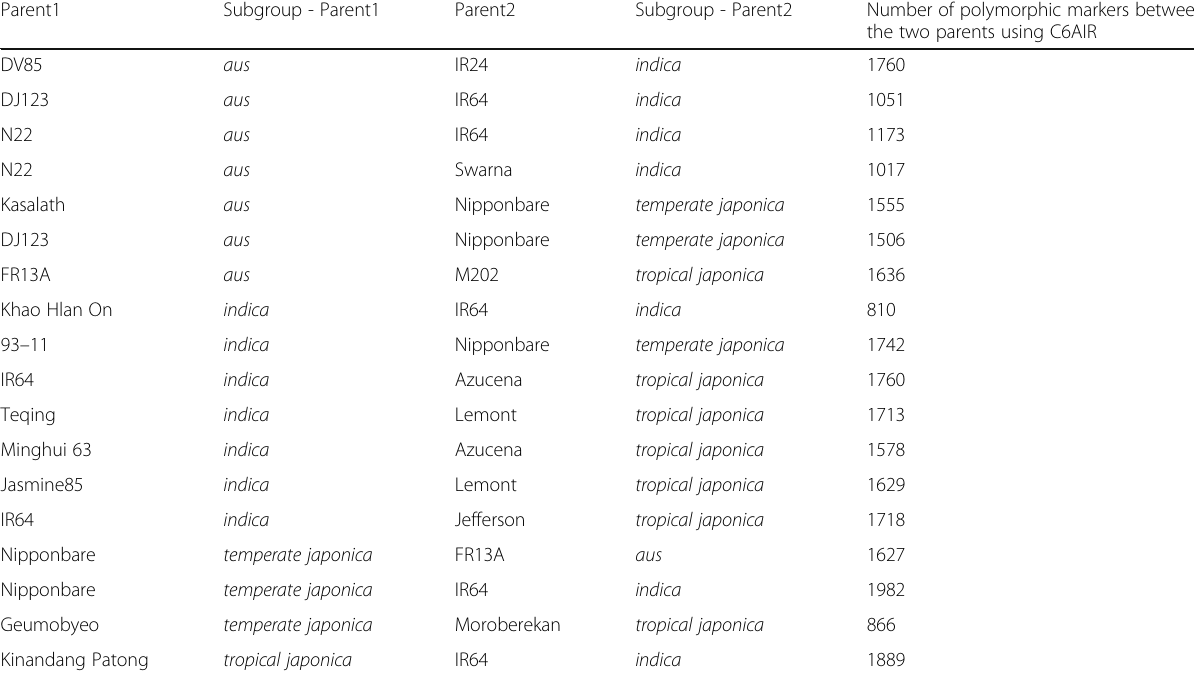
Table 1 Number of polymorphic SNPs detected by C6AIR in 18 bi-parental populations commonly used for mapping in rice. On average a 1 Mb region contains around 3 – 6